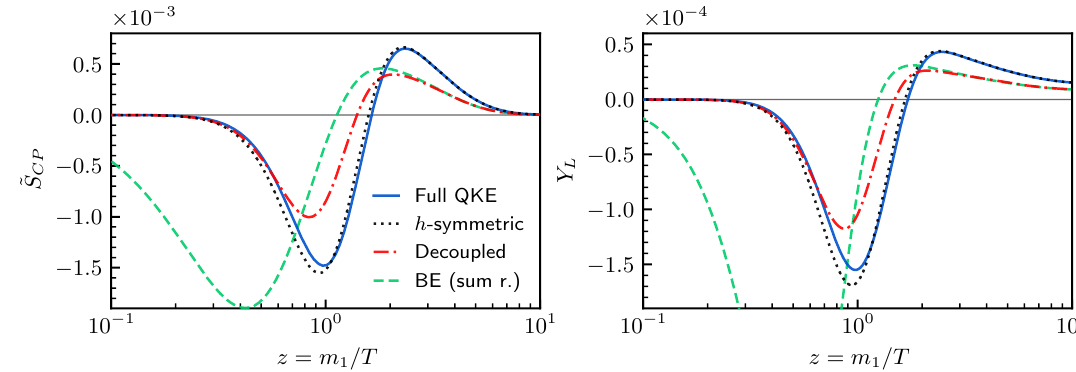
Figure 11. Comparison of the full results (solid line) to the helicity-symmetric approximation (dotted), decoupling limit (dash-dotted) and Boltzmann results with the sum regulator (dashed). We show the results for the lepton asymmetry source term (left) and the lepton asymmetry itself (right) as functions of z . The benchmark parameters with vacuum initial conditions were